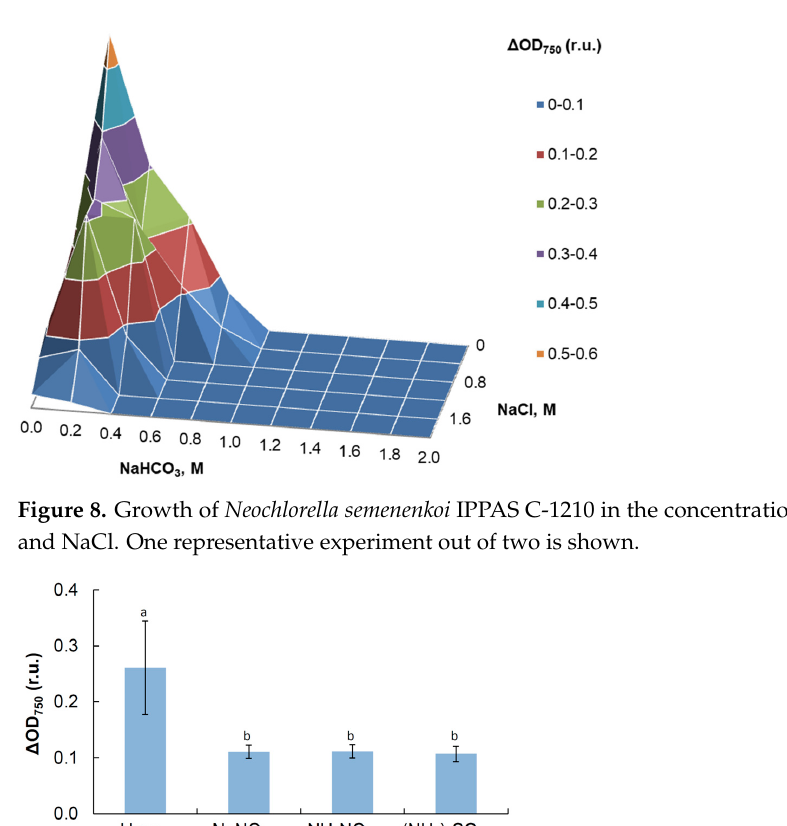
Figure 8. Growth of Neochlorella semenenkoi IPPAS C-1210 in the concentration matrix of NaHCO 3 and NaCl. One representative experiment out of two is shown.